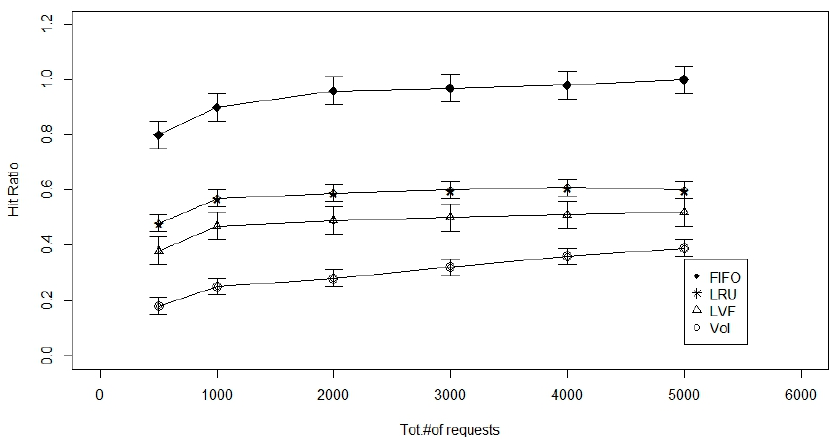
Figure 3. Cache size versus the hit ratio with 2-level caching.